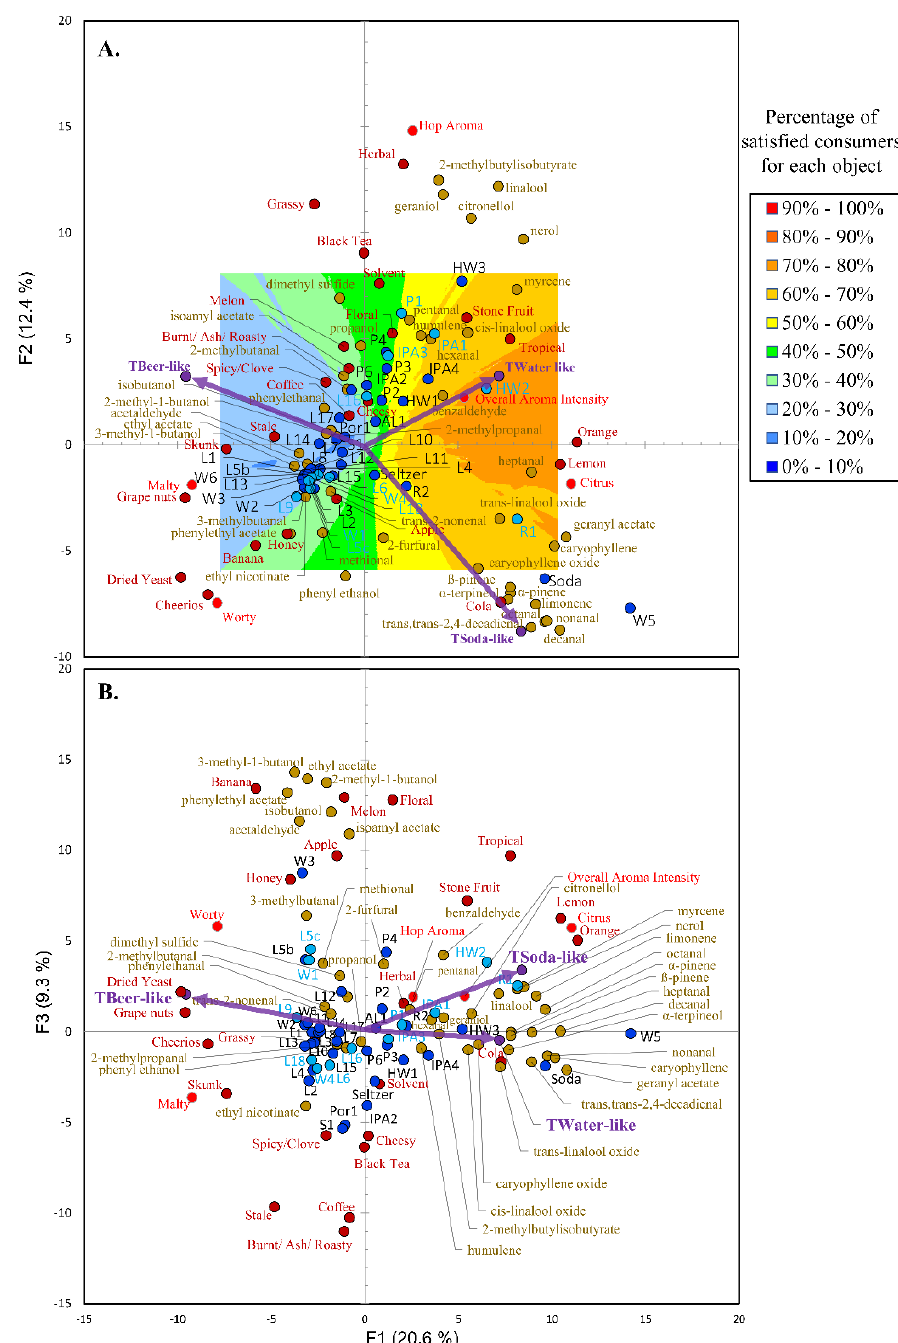
Figure 2. Principle component analysis biplots of the beer-like, soda-like, water/flavored water-like ratings (purple circles/arrows, Table 1) for the trained panel along with the statistically different aroma attributes (Light red circles (DA terms) and dark red circles (CATA terms)) amongst the different products (light- and dark-blue circles, Table 1) and volatiles (light brown circles). The samples highlighted by the dark blue circles were evaluated only by the trained panel, whereas the samples highlighted by the twelve light blue circles were also evaluated by consumer analysis. PC1 and PC2 ( A ) described 33.0% of the variation in the data, while PC1 and PC3 ( B ) accounted for an additional 9.3%. External preference mapping (using F-ratios to find the best vector model, p < 0.05, contour plot threshold % = 100) was performed as described in Section 3.2. The consumers were least satisfied with the products in the dark blue region, whereas consumers were more satisfied with the products in the dark red/ orange region.